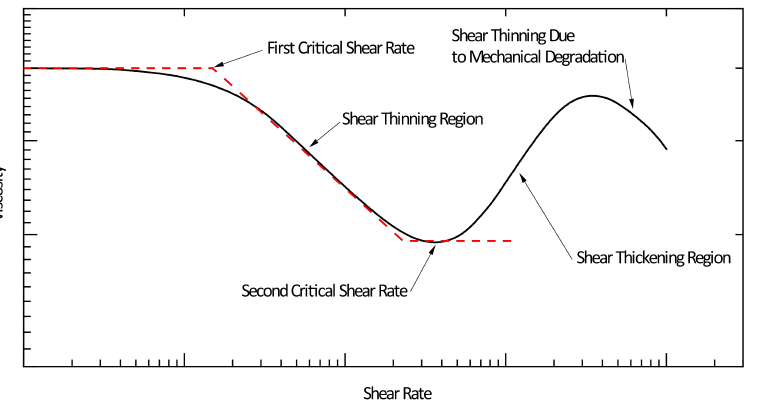
Figure 8. Schematic diagram of a shear-thinning/-thickening polymer solution, showing the vis- coelastic behavior exhibited by these in porous media (reprinted/adapted with permission from